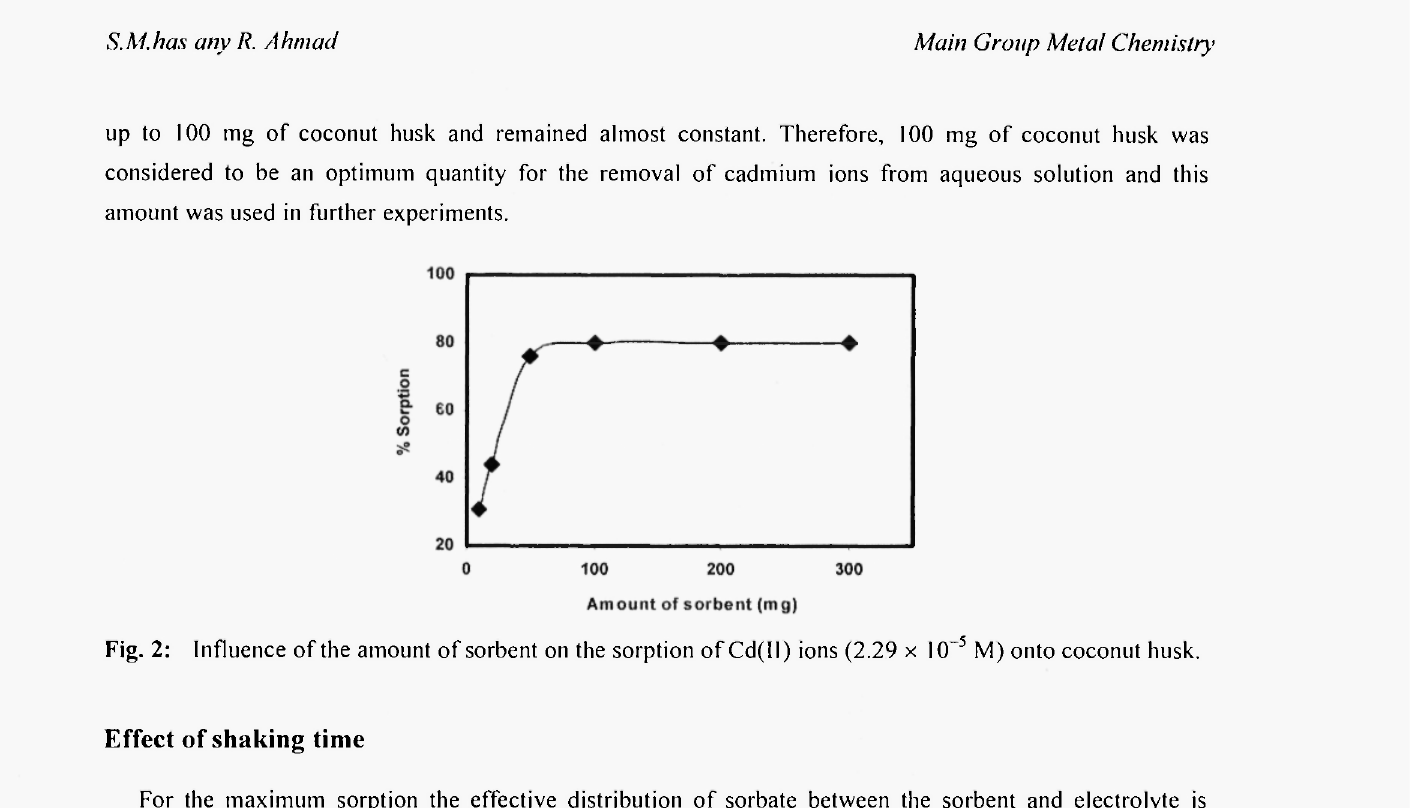
Effect of shaking